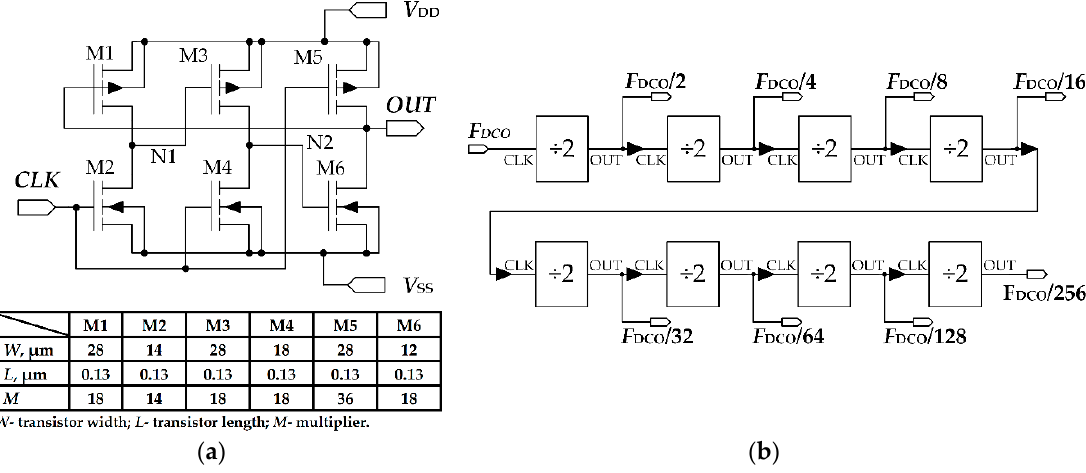
Figure 5. Extended true single phase clock (E-TSPC) frequency divider: ( a ) divide by two stage schematic; ( b ) block diagram.